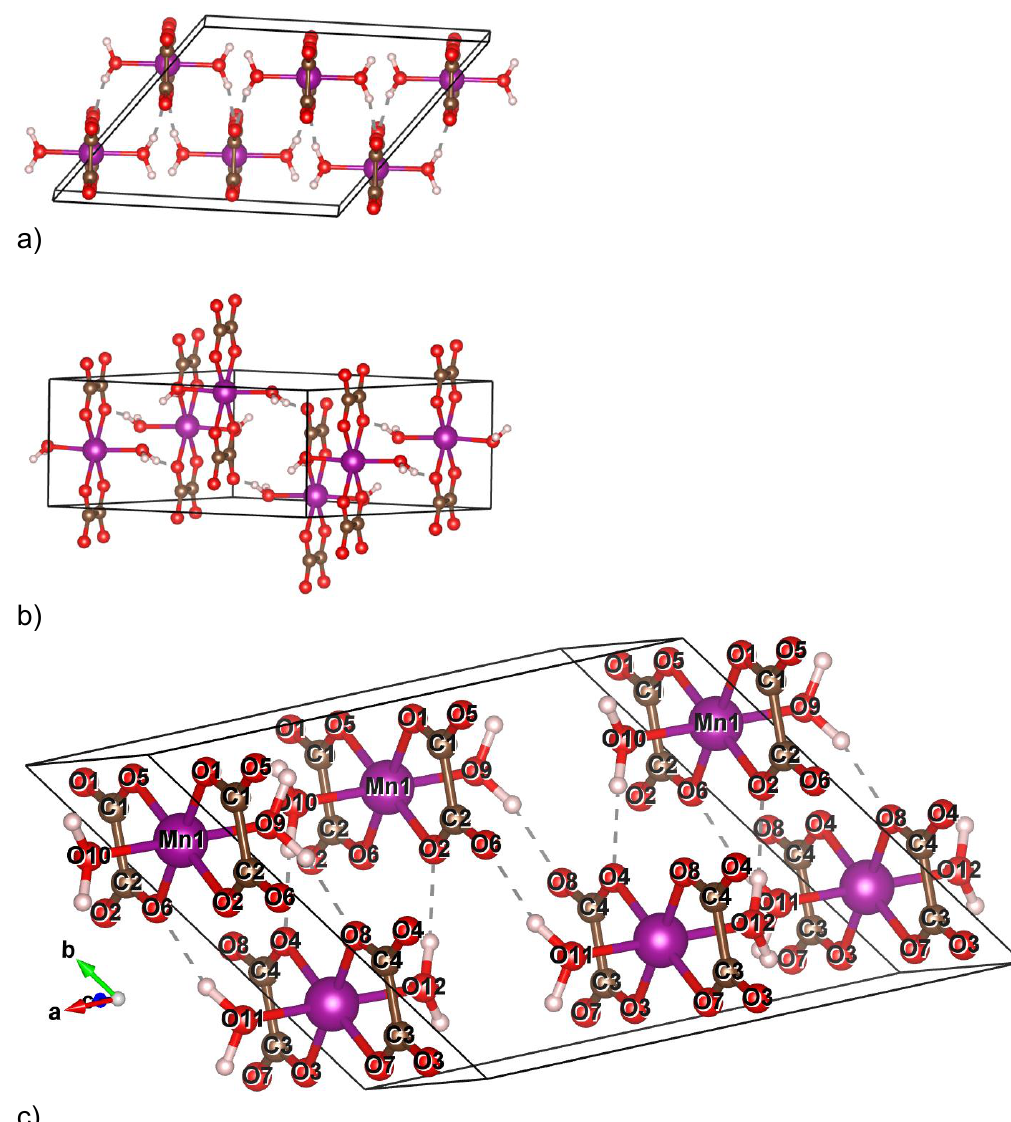
Figure 1: Molecular structure of a α - MnC2O4.2H2O: a) on top view; b) side view c)